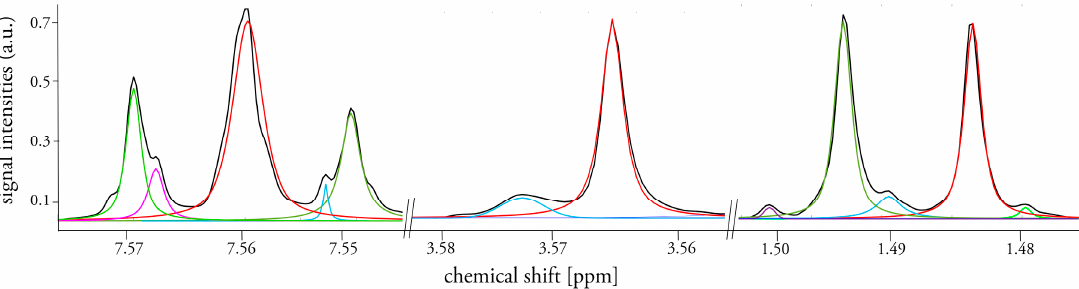
Figure 2. Typical fit results for an exemplary urine spectrum in three regions where signals overlap and/or small peaks are present; initial spectrum is shown as black line, fitted peaks are depicted in colored lines.